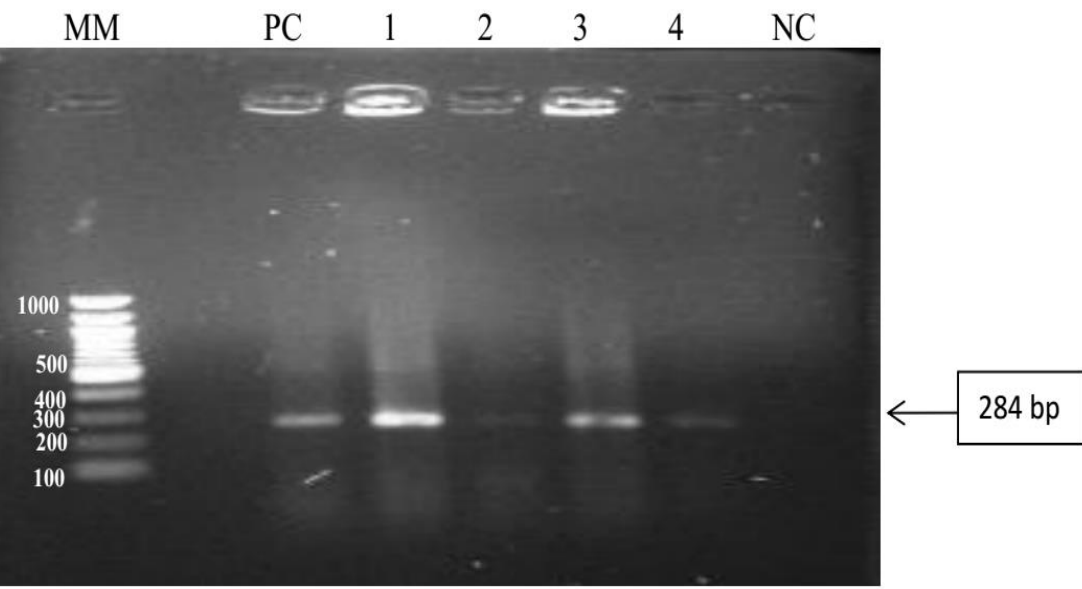
Figure. 1. PCR amplification of inv A gene Lane MM: Molecular weight markers 100 bp DNA ladder; Lane PC: Positive control (ATCC 14028); Lanes 1-4: Samples positive for Salmonella